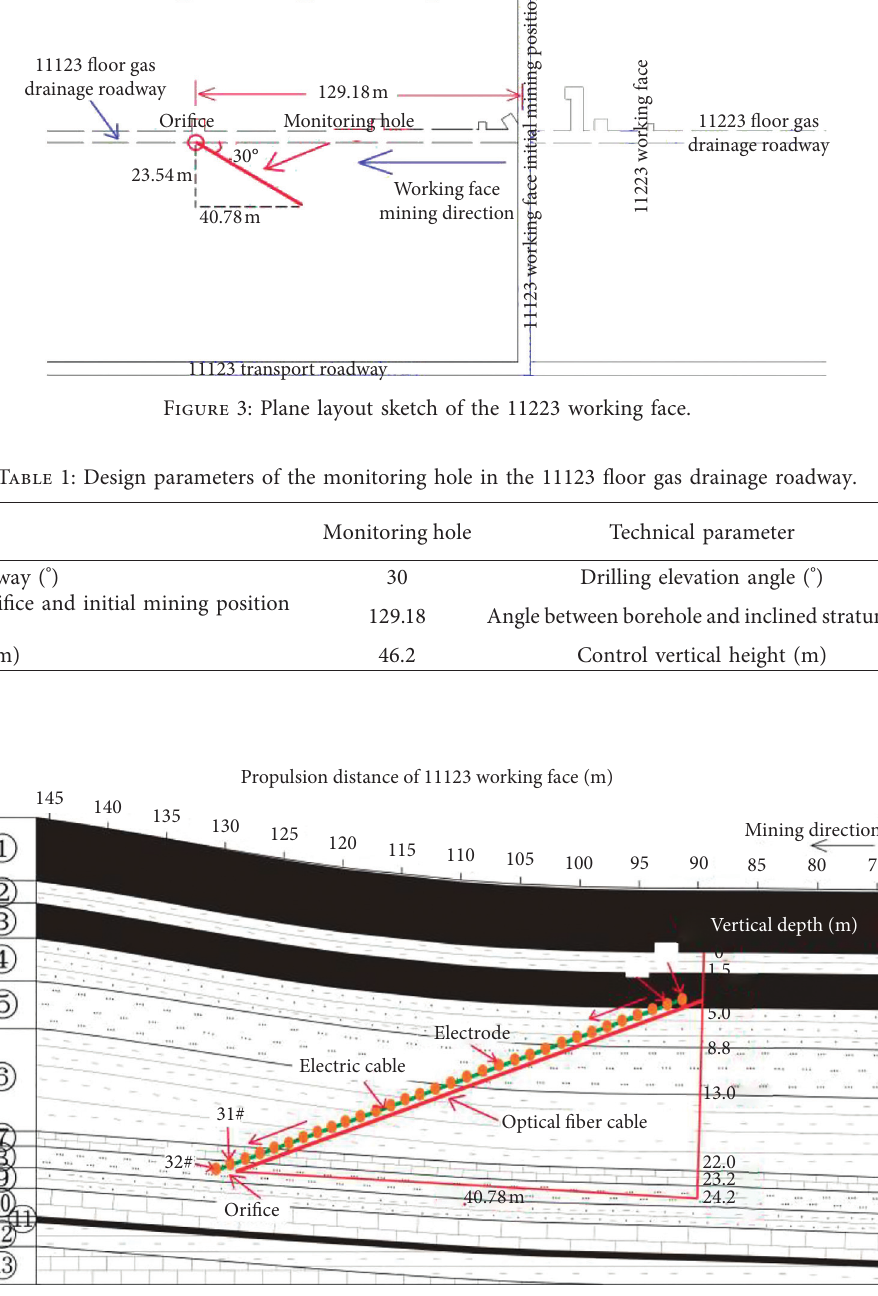
Figure 4: Schematic diagram of cable arrangement for the integrated monitoring system. Table 2: Technical parameters of the integrated monitoring